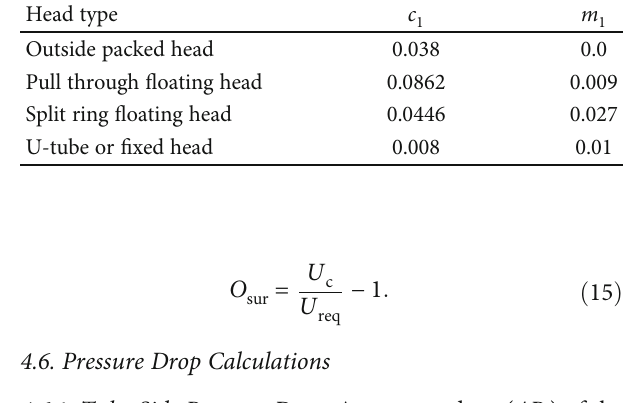
Table 3: Coe ffi cients c